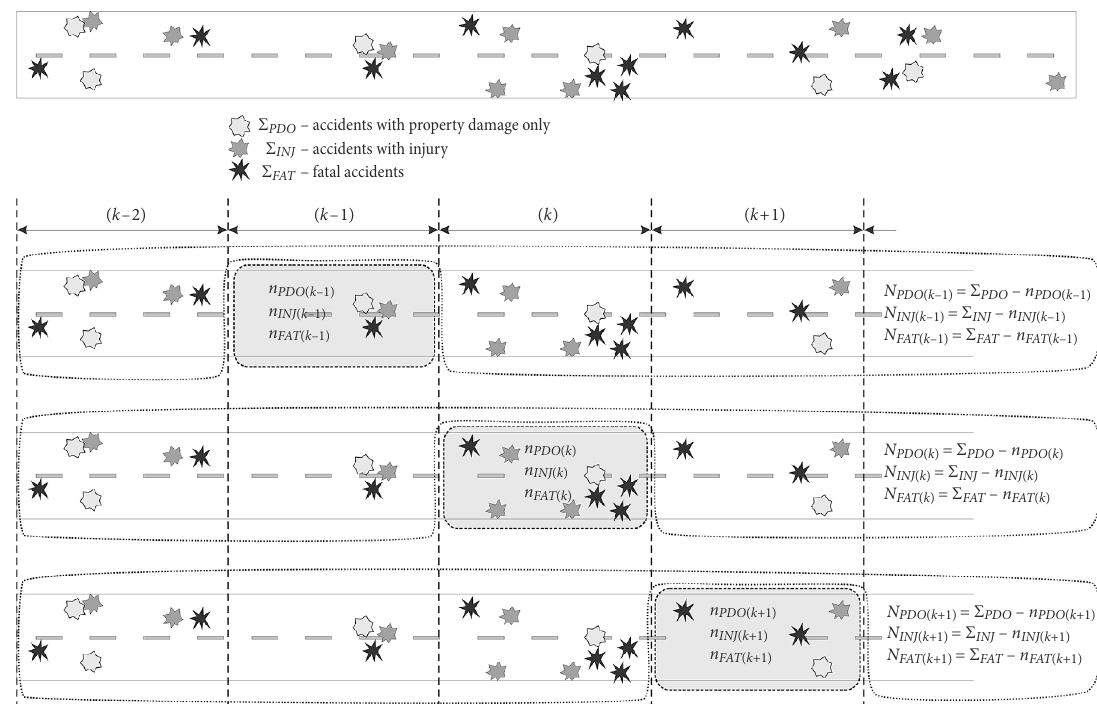
Fig. 2. Distribution of traffic accidents at disjunctive